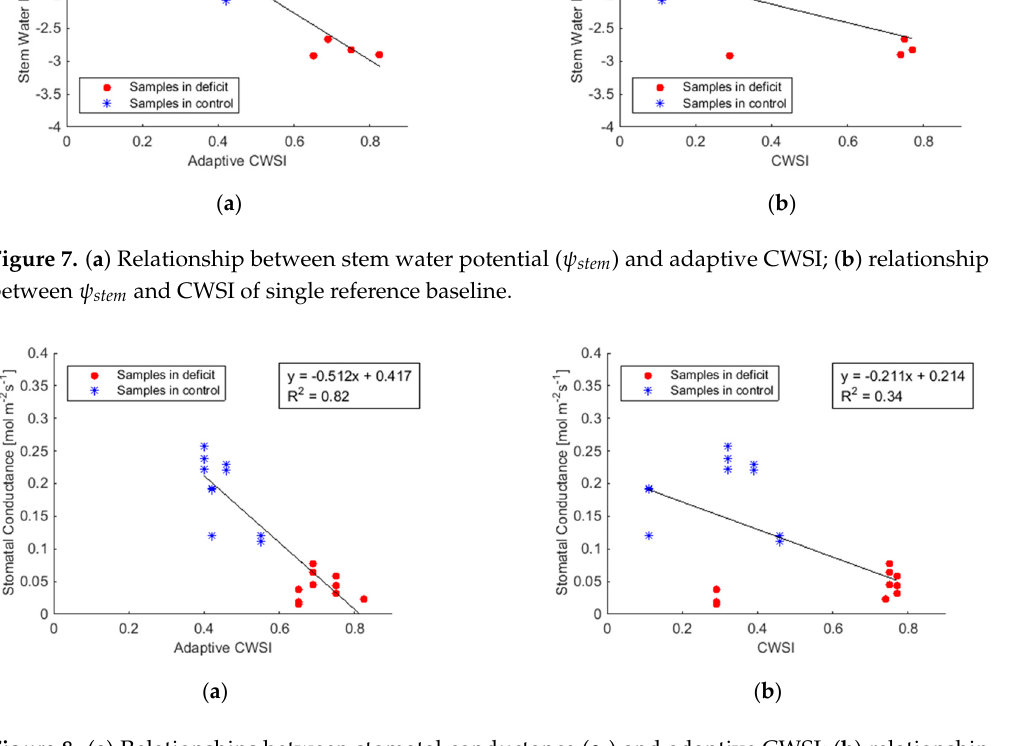
Figure 8. ( a ) Relationships between stomatal conductance ( g s ) and adaptive CWSI; ( b ) relationship between g s and CWSI of single reference baseline.